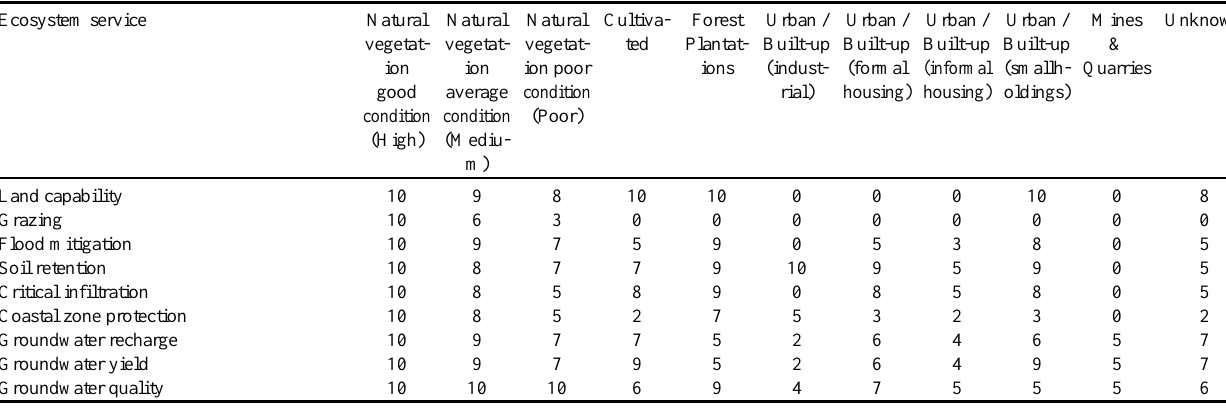
Table 1 . Ecosystem services scored for different land use classes based on expert opinion. Scores were rated on a scale from 0 to 10 where 0 represented no service and 10 the maximum potential